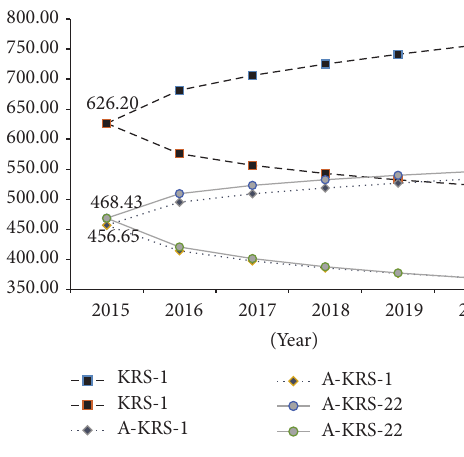
Figure 5: The cost fluctuation rang using confidence intervals derived from the ARIMA